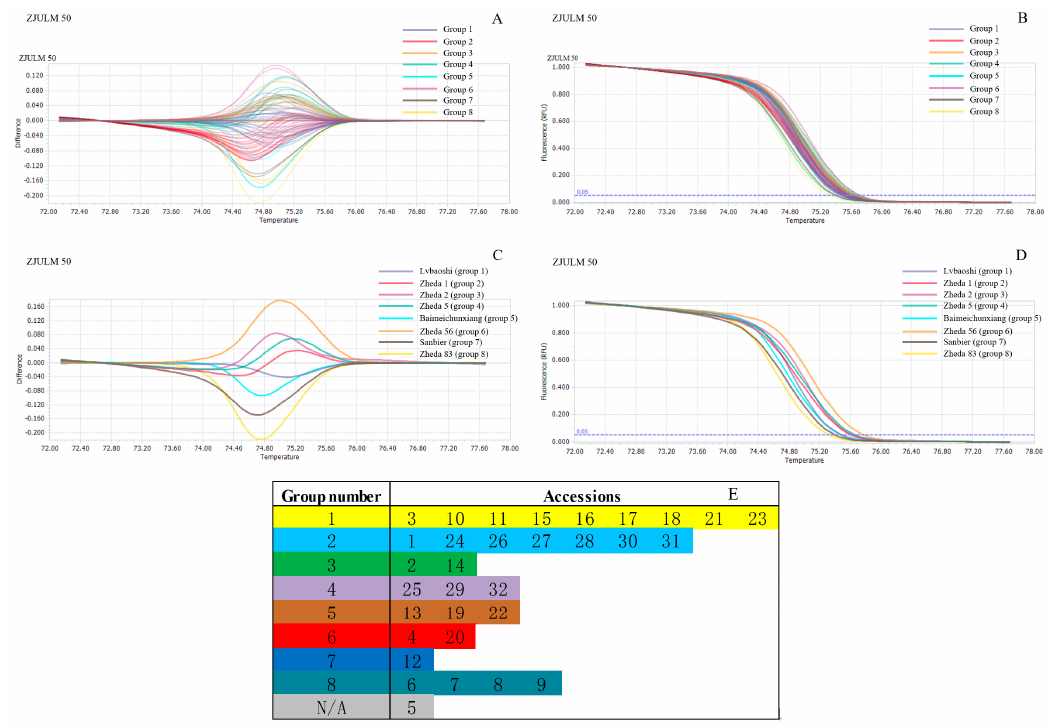
Figure 6. Difference plots and normalized HRM melting curve analyses obtained with the SSR marker ZJULM 50: ( A ) difference plots of 32 Luffa accessions (each amplicon with three repeats) by the genomic SSR marker ZJULM 50; ( B ) normalized HRM melting curve of 32 Luffa accessions (each amplicon with three repeats) by the genomic SSR marker ZJULM 50, where the same line color indicates the same genotype calculated by HRM analysis; ( C ) difference plots of the eight distinguished Luffa accessions by the genomic SSR marker ZJULM 50; ( D ) normalized HRM melting curve of the eight distinguished Luffa accessions by the genomic SSR marker ZJULM 50; and ( E ) genotype group number of each accession. Blue dotted line 0.05 in ( B ) and ( D ) meant Fluorescence (RFU) = 0.05. Table 5. Result of genotype group number obtained with 19 SSR markers. ZJU Luffa Accession Number